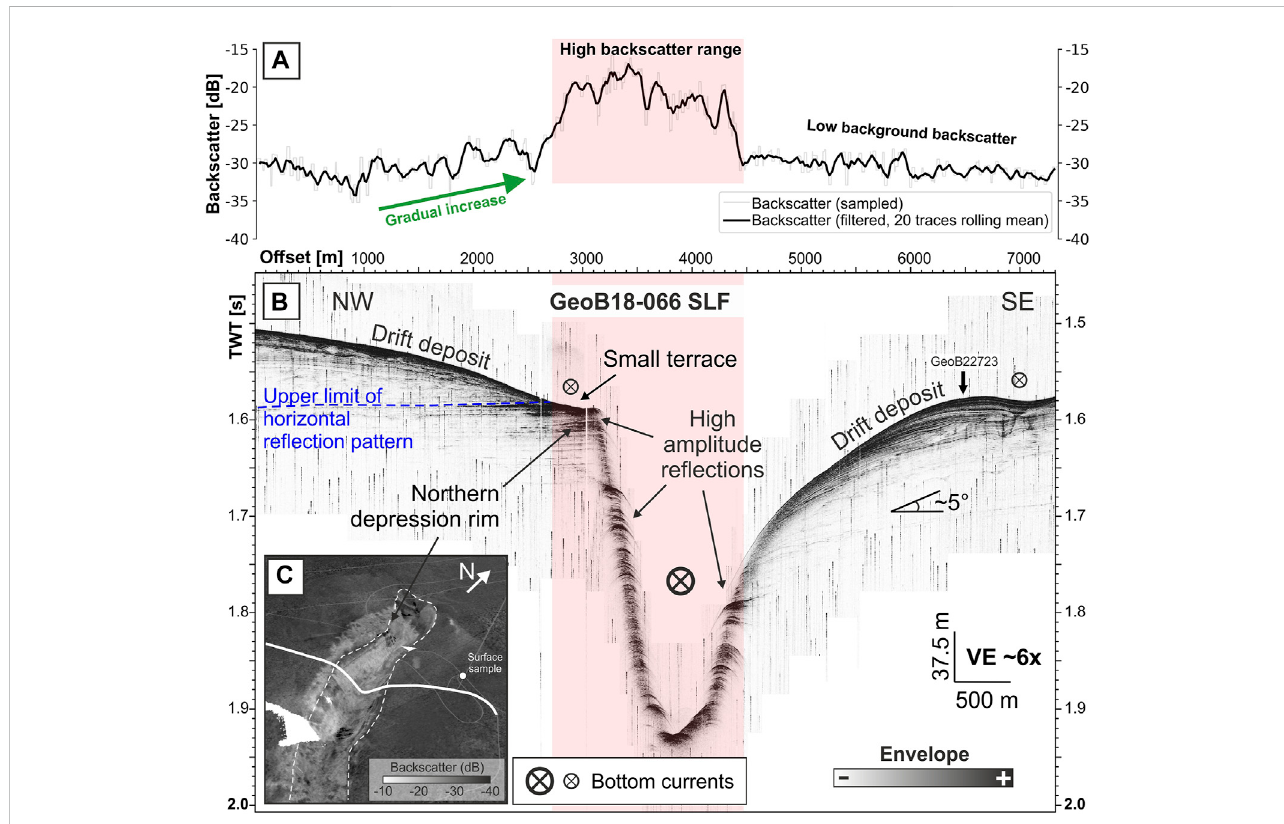
FIGURE 5 (A) Sampled (light grey line) and smoothed (black) backscatter intensities from a mosaic (25 m resolution) along (B) PARASOUND pro fi le GeoB18-066 (4 kHz SLF envelope) crossing the northern sub-depression of SD-N. Area of high backscatter values marked with light red rectangles correlates with high amplitudere fl ectionsintheacousticpro fi le. (C) PerspectiveviewofSD-NfromSWshowingthespatialextentofhighbackscatterintensities(whitecolors)and location of pro fi le (thick white line). For the exact location of the pro fi le, refer to Figure